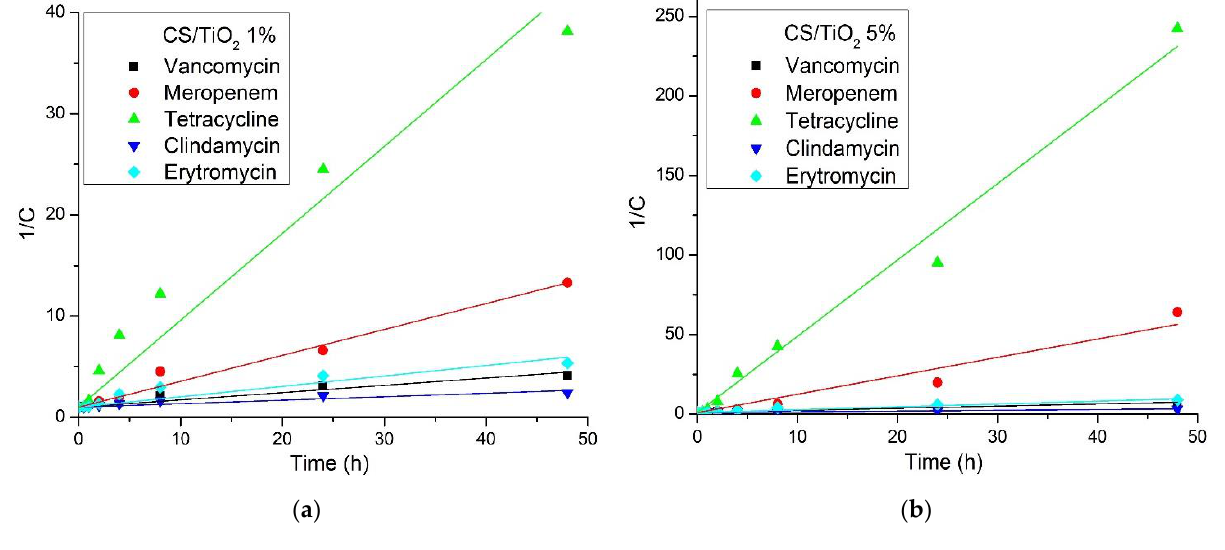
Figure 14. The plots of ln(C 0 /C) vs. irradiation time (t) for ( a ) CS/TiO 2 1% and ( b ) CS/TiO 2 5% membranes.